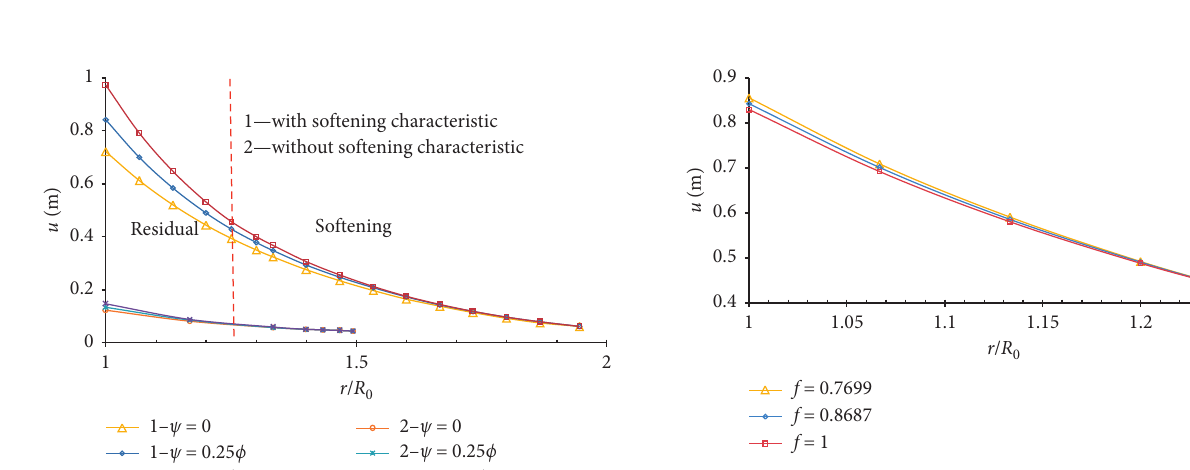
Figure 5: Displacements of surrounding rock in strain-softening